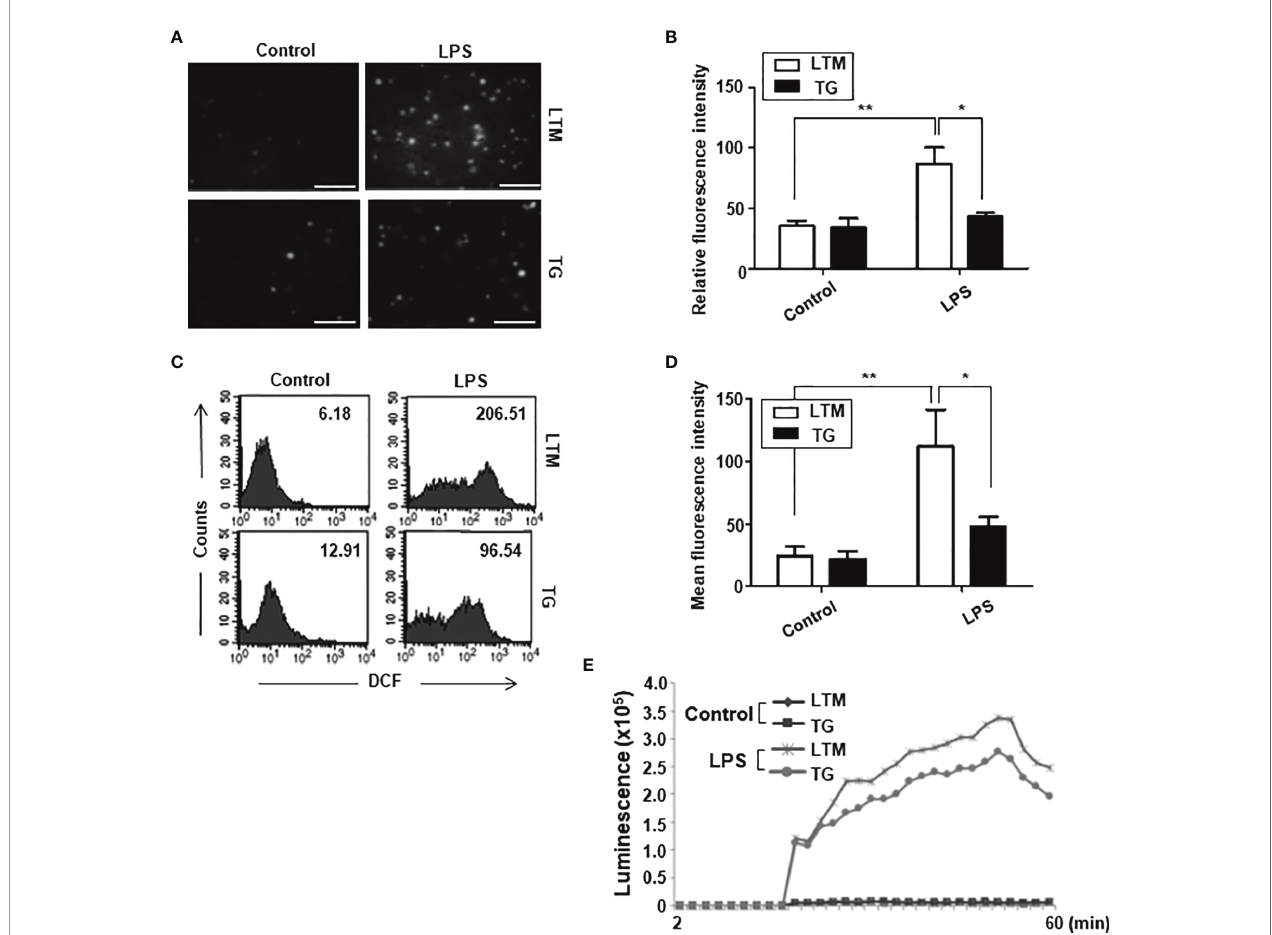
FIGURE 4 | Analyses of ROS production in the PMs of LTM and p190RhoGEF TG mice. (A) Images show LPS-mediated ROS production in PMs from LTM and TG mice. PMs (1 x10 6 ) that were loaded with 5 m M DCFDA for 15 minutes were stimulated with LPS (1 m g/ml). Representative microscopic fi elds of DCF fl uorescence from the cells after a 30-minute stimulation with either control (PBS) or LPS are shown. Scale bars = 50 m m. (B) The DCF fl uorescence intensity of PMs from LTM and TG mice after a 30-minute stimulation with LPS is shown. The data are the averaged intensities from three microscopic fi elds (10 cells in each fi eld). The data are presented as the mean ± SEM. Statistical signi fi cance was analyzed by one-way ANOVA with Tukey ’ s multiple comparison tests. Signi fi cant comparisons are noted as * p < 0.05, ** p < 0.01. The experiments were repeated three times. (C) LTM and TG PMs (2.5 x10 5 ) were loaded with 5 m M DCFDA for 15 minutes and then stimulated with LPS (100 ng/ml) for 30 minutes. The DCF fl uorescent cells were measured using fl ow cytometry. The numbers indicate the mean fl uorescence intensity (MFI). The data shown are representative of at least fi ve separate experiments. (D) The MFI of PMs from LTM and TG mice after a 30-minute stimulation with LPS is compared and the data are presented as the mean ± SEM. Statistical signi fi cance was analyzed by one-way ANOVA with Tukey ’ s multiple comparison tests (* p < 0.05, ** p < 0.01). (E) LTM and TG PMs cultured in a black 96-well plate (1.5 x10 5 /well) were stimulated with LPS (100 ng/ml). Luminescence was detected 2 minutes after adding lucigenin (200 m M) for 60 minutes at 2-minute intervals. Experiments were repeated twice with similar